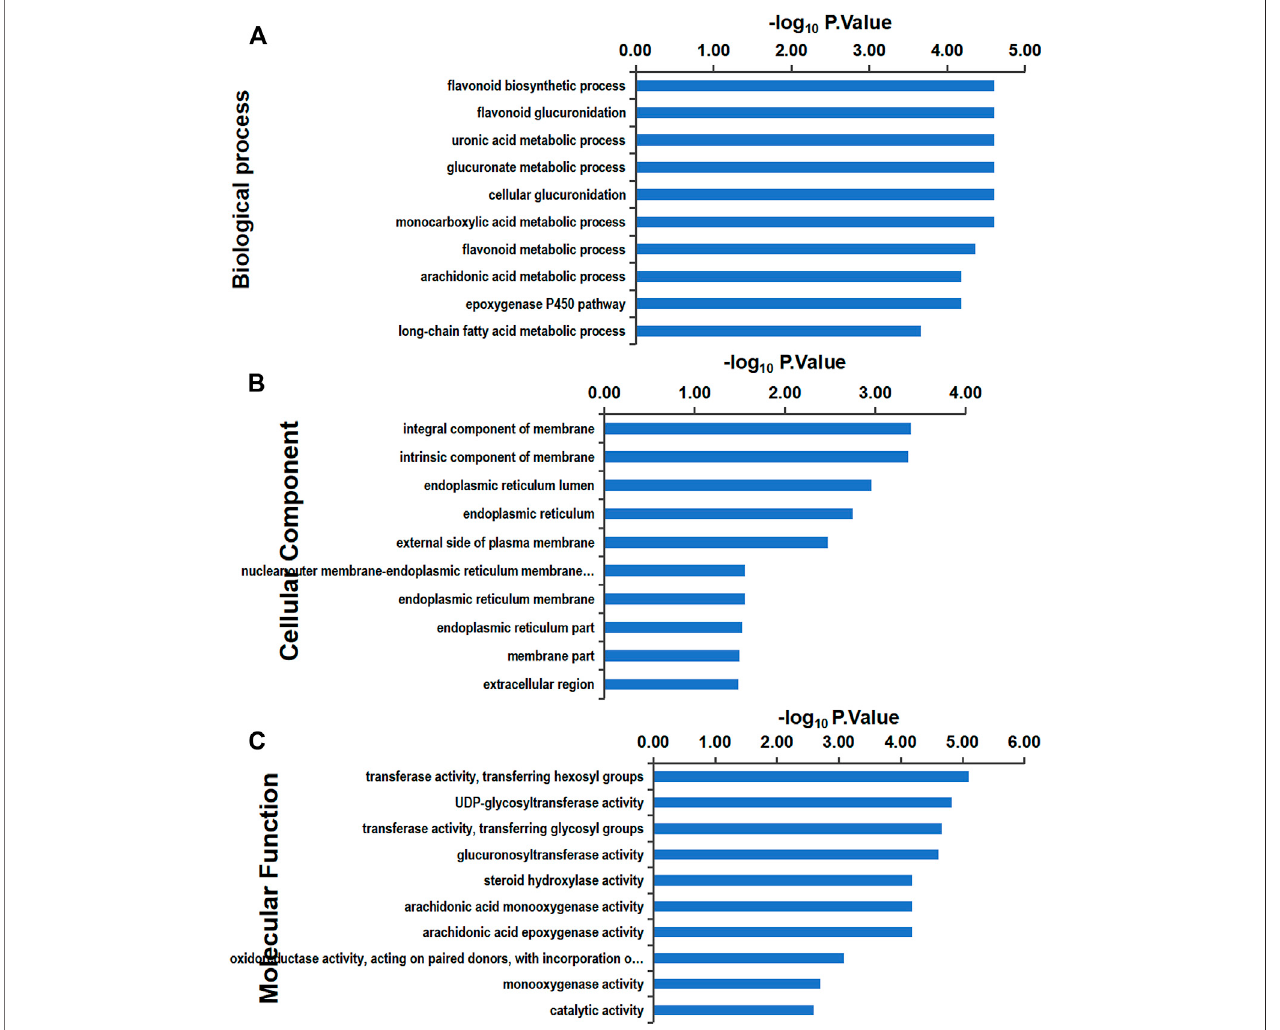
FIGURE 8 | GO enrichment analysis: the ordinate is the GO item, and the abscissa represents the enrichment of differential proteins in corresponding functional items. The largerthe value of – log10 p -valueis, themore relevantthe differential proteins aretothe function, and the analysisofdifferential proteins with thisfunction can befocusedon.GeneOntology(GO)functionalclassi fi cation (A) GOannotationintermsofcellularcomponents. (B) GOannotationintermsofmolecularfunction. (C) GO annotation in terms of biological processes.